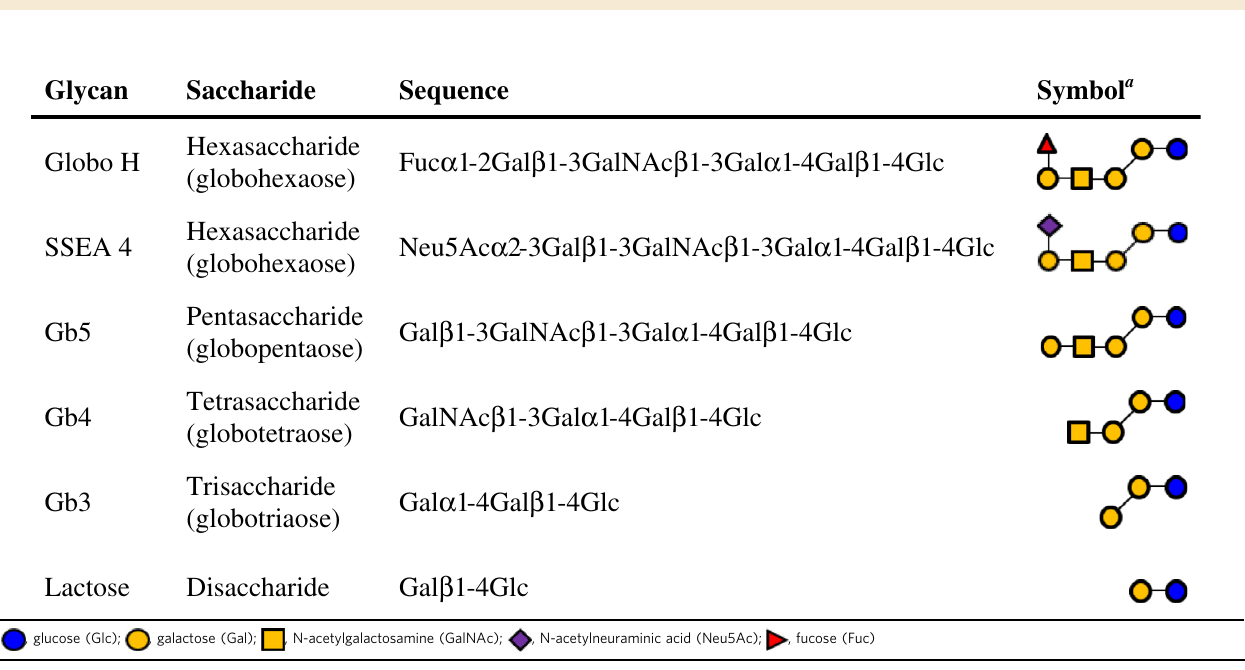
Table 1 Glycans used in this work and their